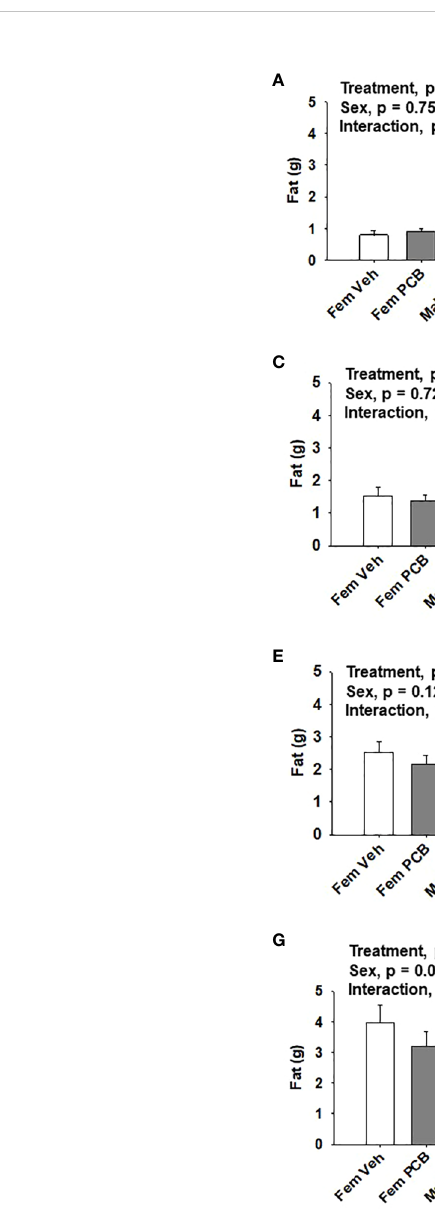
throughout the study (Figure 1B, p = 0.003; Figure 1C, p < 0.001; Figure 1D, p < 0.001; and Figure 1E, p < 0.001). Nursing exposure to PCB126 did not result in any difference in the body weight of offspring during the study (Figure 1B, p = 0.575; Figure 1C, p = 0.070; Figure 1D, p = 0.647; and Figure 1E, p = 0.768). No interactions between sex and treatment were observed in regards to offspring body weight (Figure 1B, p = 0.915; Figure 1C, p = 0.884; Figure 1D, p = 0.542; and Figure 1E, p = 0.160).